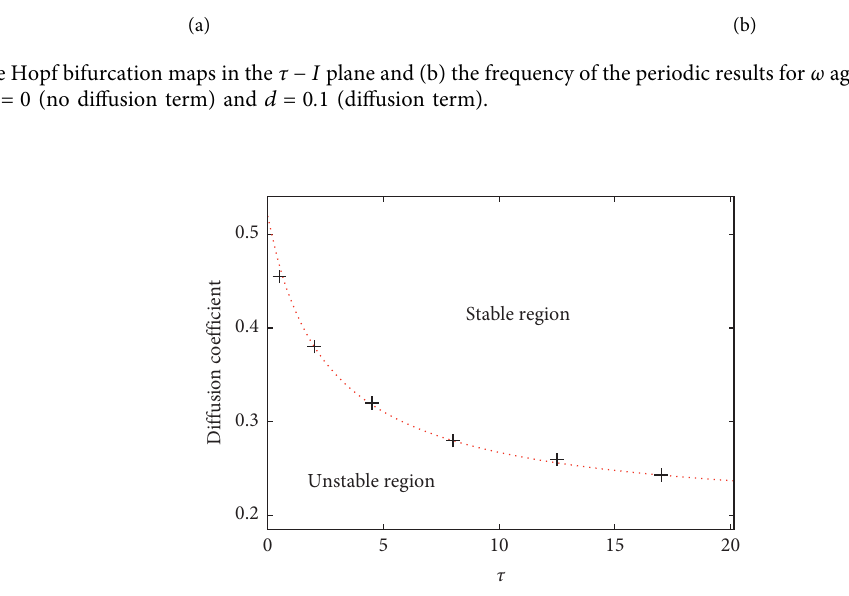
Figure 7: The Hopf bifurcation curve on the τ − d map. The analytical (red dotted line) and numerical simulation (black crosses) results are